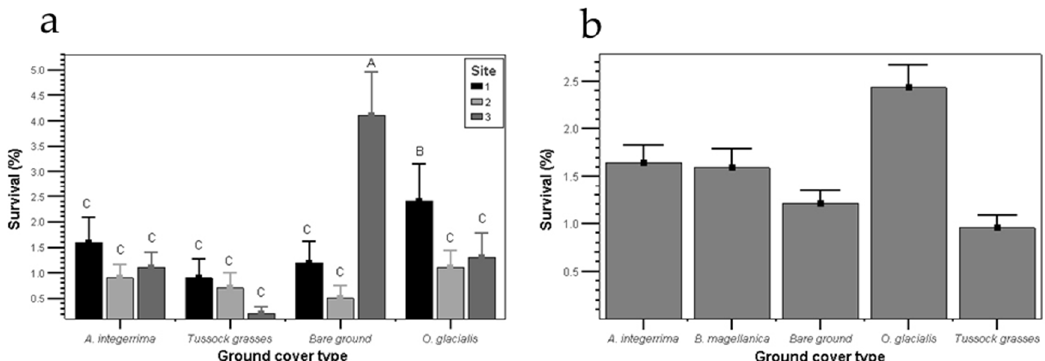
Figure 9. Survival (%) of emerged seedling of the 20 Experimental Units established on each ground cover type in three study sites. Because of the lack of replication for Baccharis magellanica in site 1, results were derived from two analyses: ( a ) Seedling survival (%) on each one of the four ground cover types present in the three study sites and ( b ) mean survival (%) on each ground cover type in site 1 (including B. magellanica ).